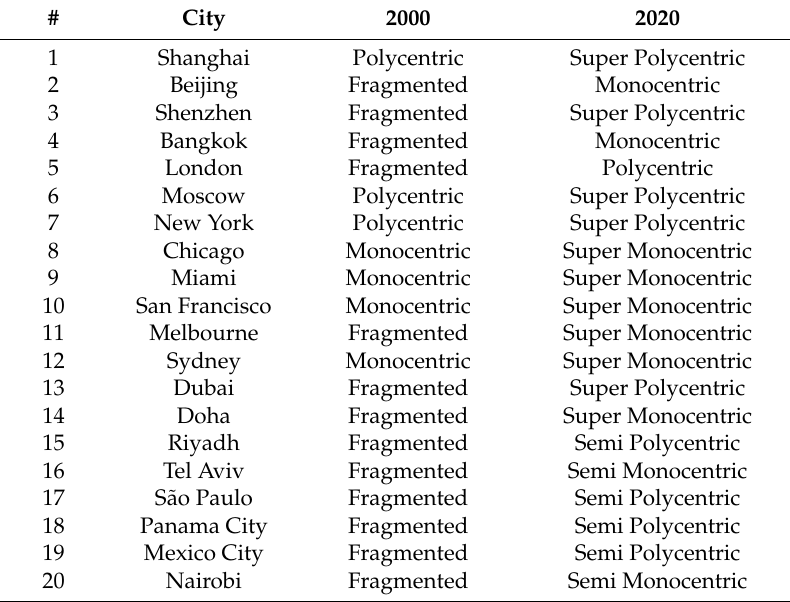
Table 36. Changing spatial patterns of skyscrapers in 2000 and